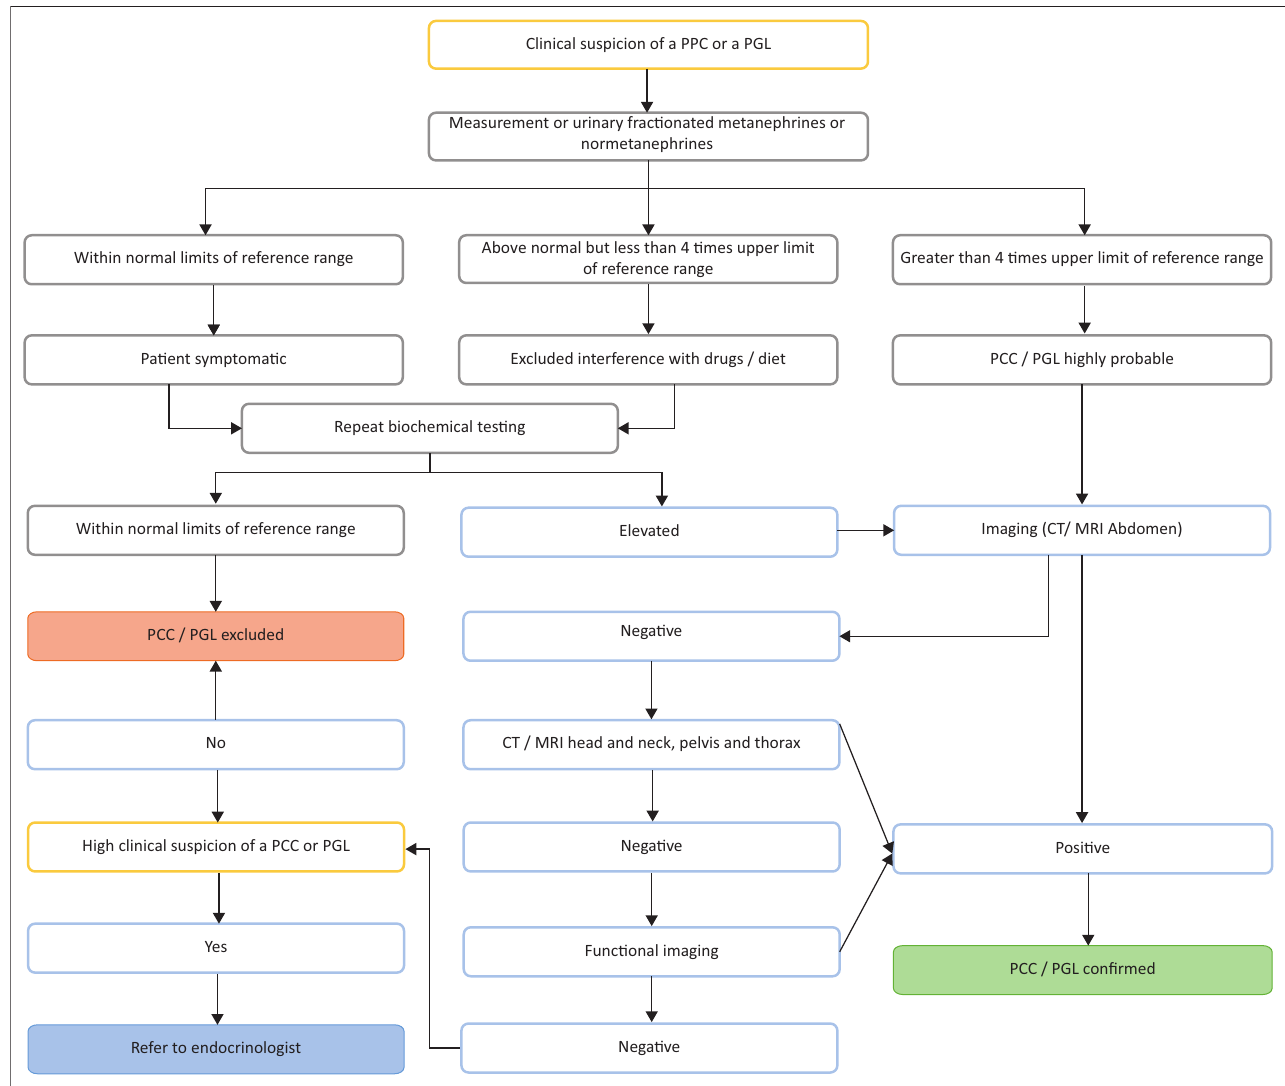
FIGURE 2: Approach to a patient with suspected pheochromocytoma and